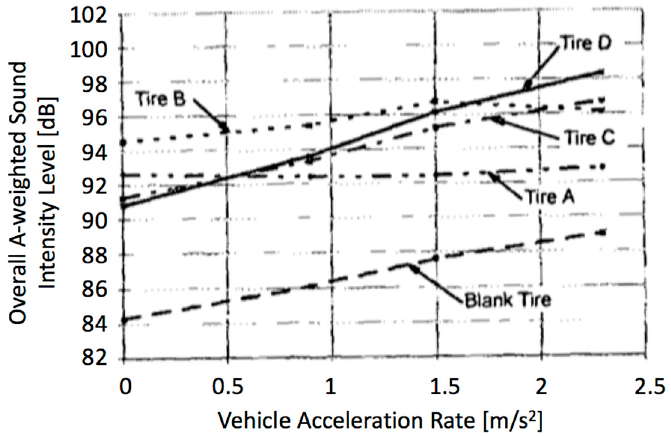
Figure 4. The effect of vehicle acceleration rate on tire noise as measured with on-board sound intensity (source from Donavan et al., 1998 [39], Figure 2; reprinted with permission from AIP Publishing LLC).